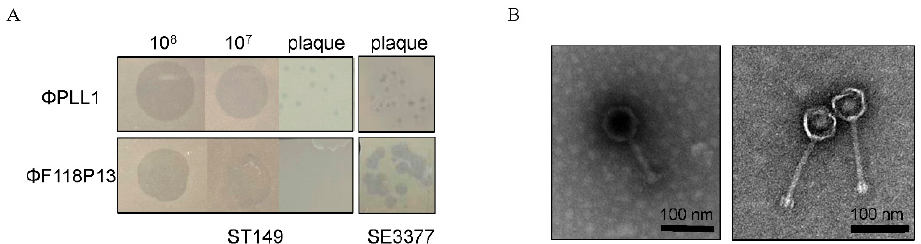
Figure 1. Morphological characteristics of Φ PLL1 and Φ F118P13. ( A ) Examples of phage plaque morphologies of Φ PLL1 and Φ F118P13 against different serotypes of Salmonella . ( B ) Transmission electron micrograph of two phages. Φ PLL1 ( left ), Φ F118P13 ( right ). Scale bar, 100 nm. Representative image is shown.